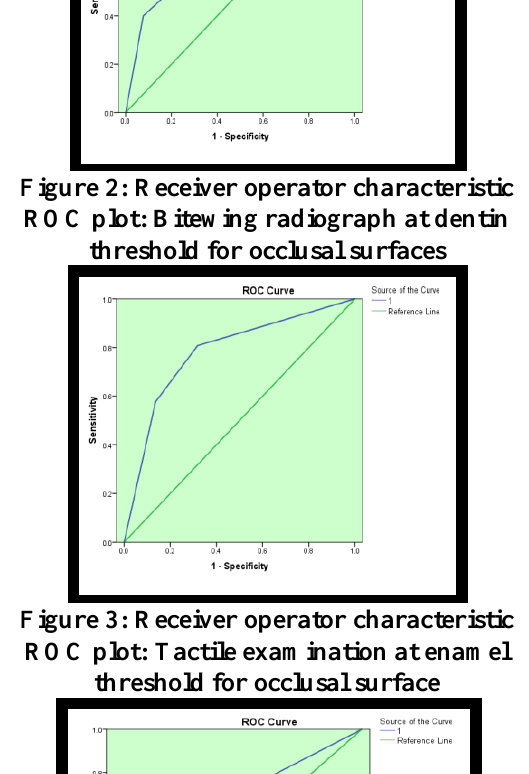
Figure 2: Receiver operator characteristic ROC plot: Bitewing radiograph at dentin threshold for occlusal surfaces